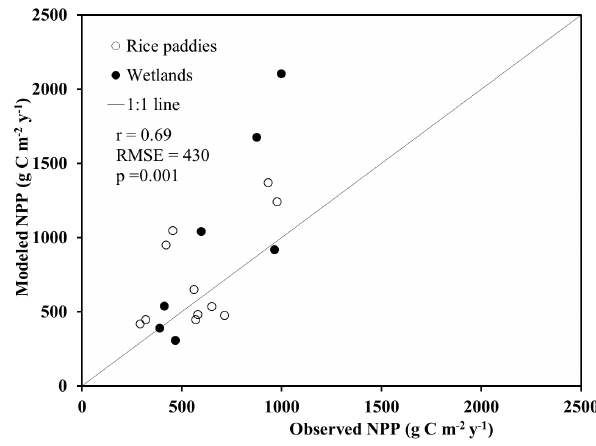
Fig. 6. Scatter plot of modeled annual NPP vs. observed annual mean NPP at the rice paddy and wetland sites. The observed annual mean NPP was obtained from MODIS (Zhao et al., 2005). r is cor- relation coefficient; RMSE indicates root-mean-square error, and p is probability level. (Alberta, Canada; Florida,